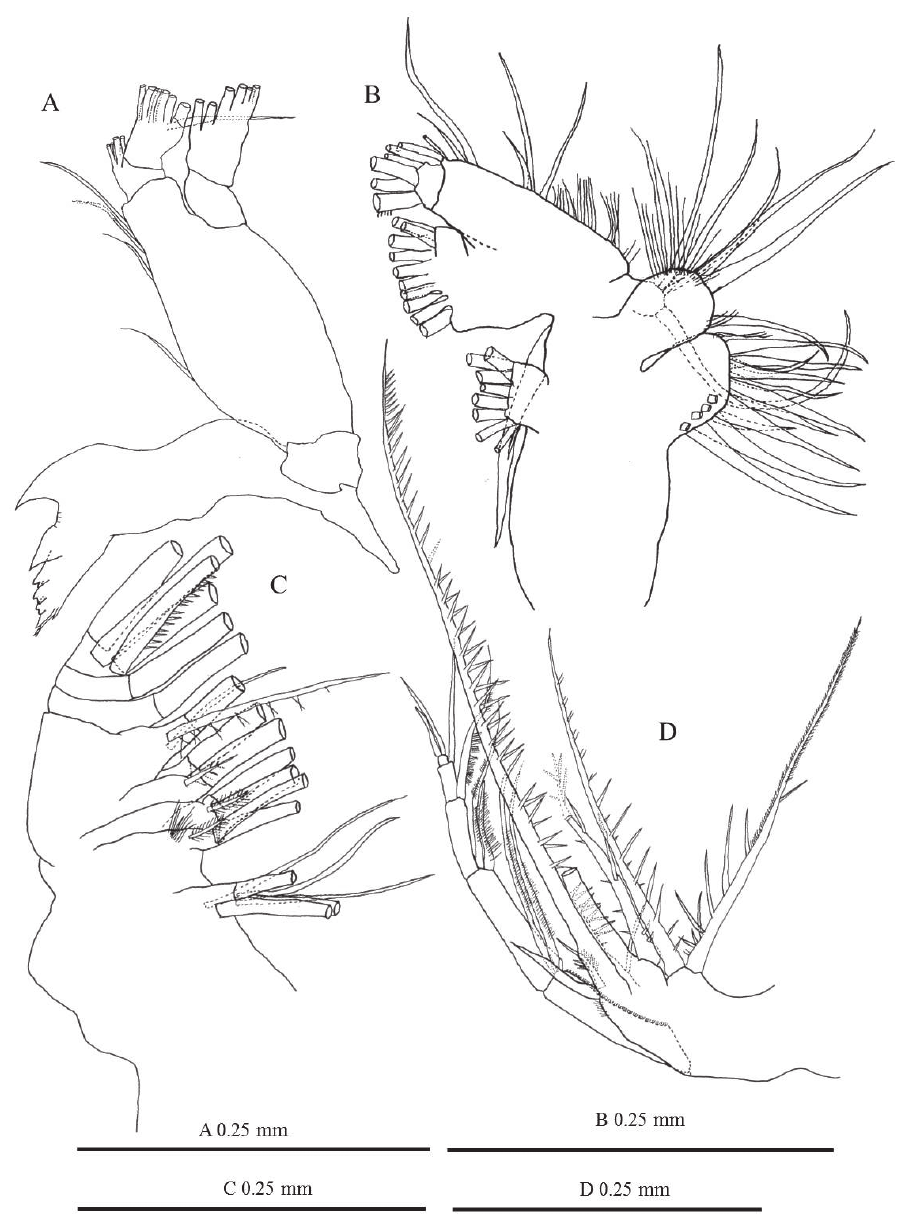
Figure 2. Labidocera churaumi sp. n., female (Paratype). A mandible B maxillule C maxilla D maxilliped.